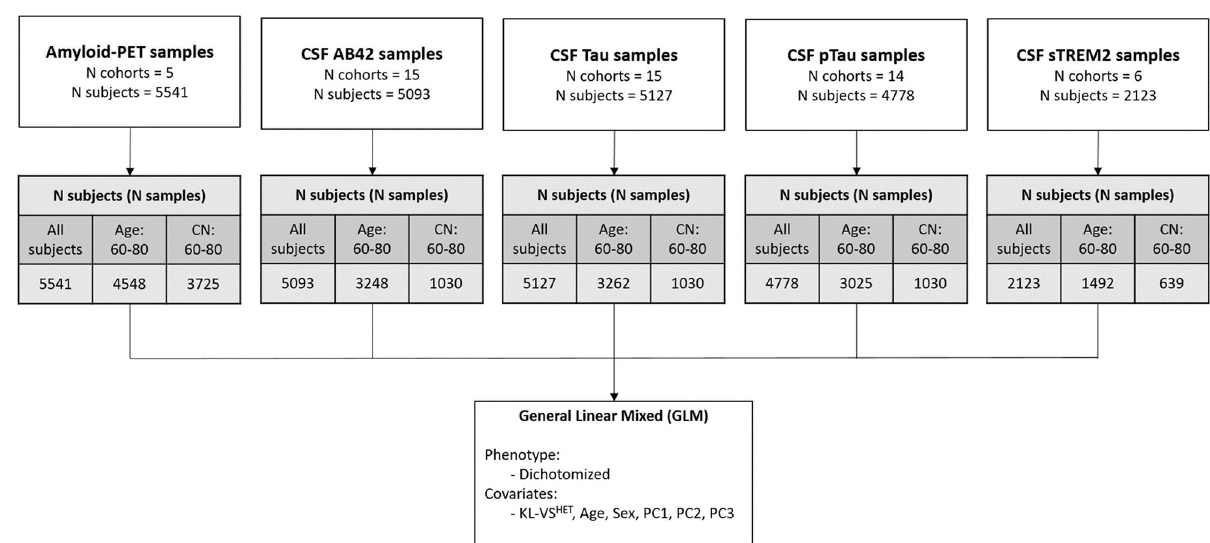
For each cohort, amyloid PET images were normalized to their reference cerebellar regions to obtain standardized uptake value ratios (SUVR) in a composite of cortical brain areas. The normalized z-scores were calculated for each endophenotype using the mean and standard deviation (SD) units across each cohort and applied to the entire endophenotype. These nor- malized z-scores were used for dichotomizing each endophenotype into biomarker positive